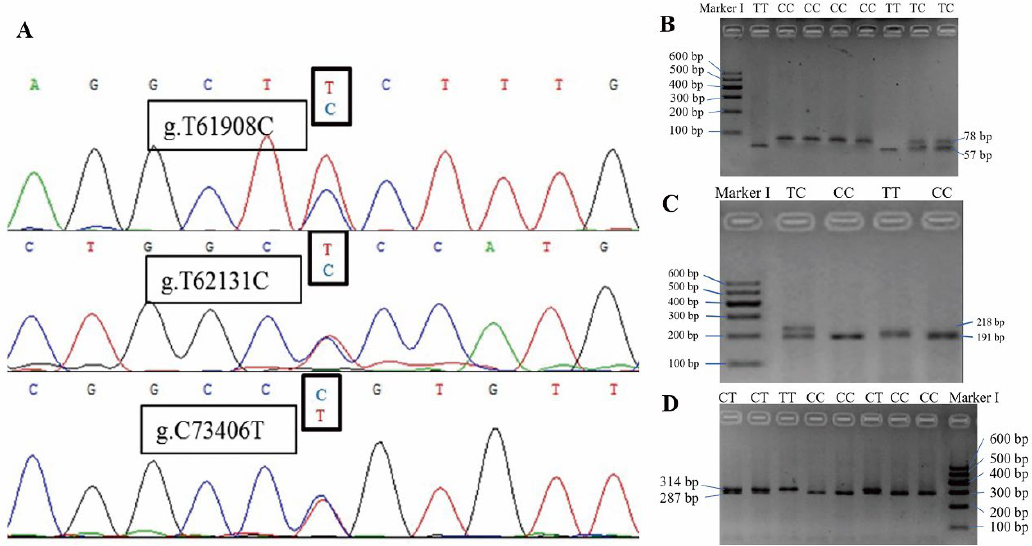
. Figure 3. Sequence variants of the KAT2B gene in bovines. ( A ) KAT2B gene polymorphism sites. ( B ) Genotyping of g.T61908C. TT genotype is represented by the combination of 21 and 57 bp bands; CC genotype is represented by 78 bp band; TC genotype is represented by the combination of 78, 57, and 21 bp bands. ( C ) Genotyping of g.T62131C. The combination of 191 and 27 bp bands represents the CC genotype; the 218 bp band represents the TT genotype; the combination of 218, 191, and 27 bp bands represents the TC genotype. ( D ) Genotyping of g.C73406T. The combination of 287 and 27 bp bands represents the CC genotype; the 314 bp band represents the TT genotype; the CT genotype is represented by the combination of 314, 287, and 27 bp bands. Table 2. Genotype and allele frequencies of SNP of the bovine KAT2B gene.